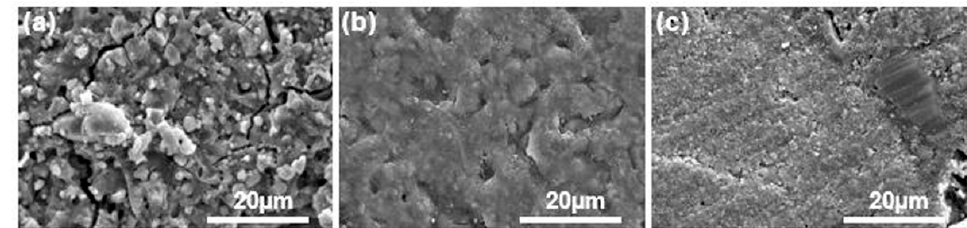
Figure 1. Scanning electron microscopy (SEM) images at 2000 × of the surfaces of the materials used in this study: FI group ( a ), RL group ( b ), and CN group ( c ).